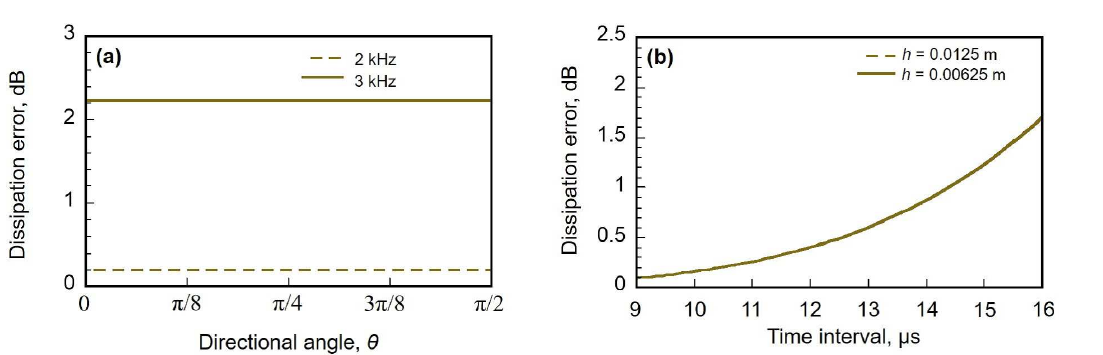
Figure 5. Theoretical dissipation error characteristics of the proposed method: ( a ) anisotropic characteristics in terms of sound propagation directions at 2 kHz and 3 kHz and ( b ) convergence of dissipation error relative to time resolution.